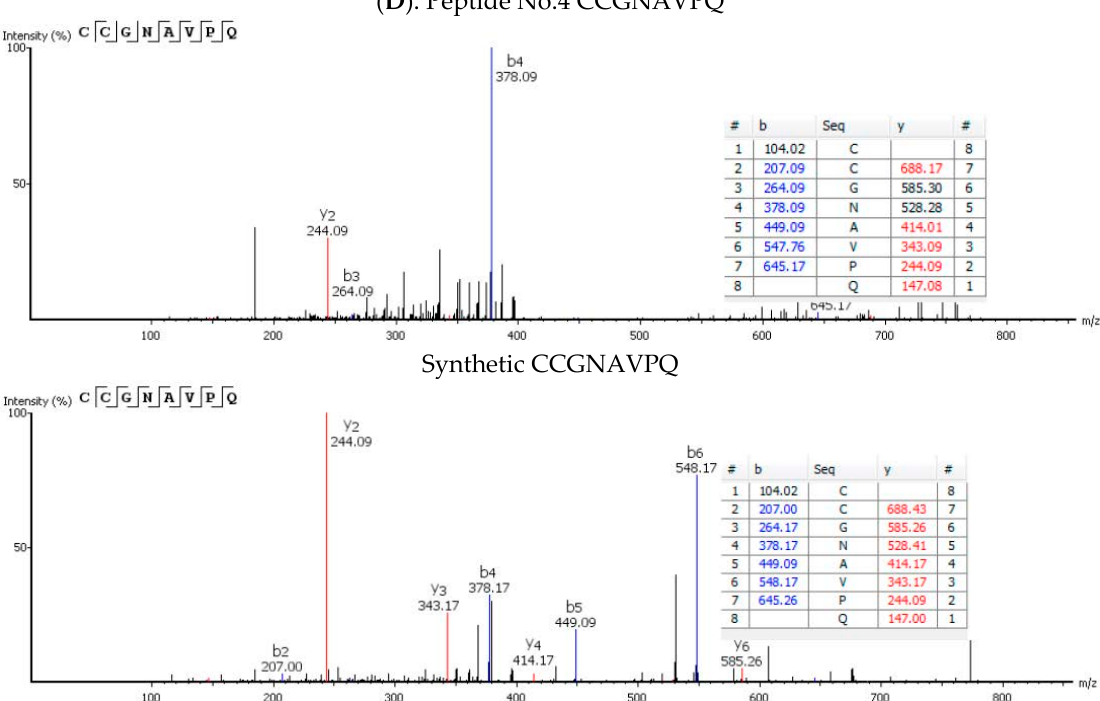
Figure 4. Fragmentation spectra of water-soluble peptides extracted from unfiltered virgin olive oil and of the corresponding purified synthetic peptides (below) analysed by nano- LC-Orbitrap MS/MS and PEAKS Studio software. ( A ), peptide No. 1, RDGGYCC; ( B ), peptide No. 2, LEEFCC; ( C ), peptide No. 3 HCGCNTH; and ( D ), peptide No. 4 CCGNAVPQ. Fragment ion tables for b and y ions (monoisotopic masses) are included.